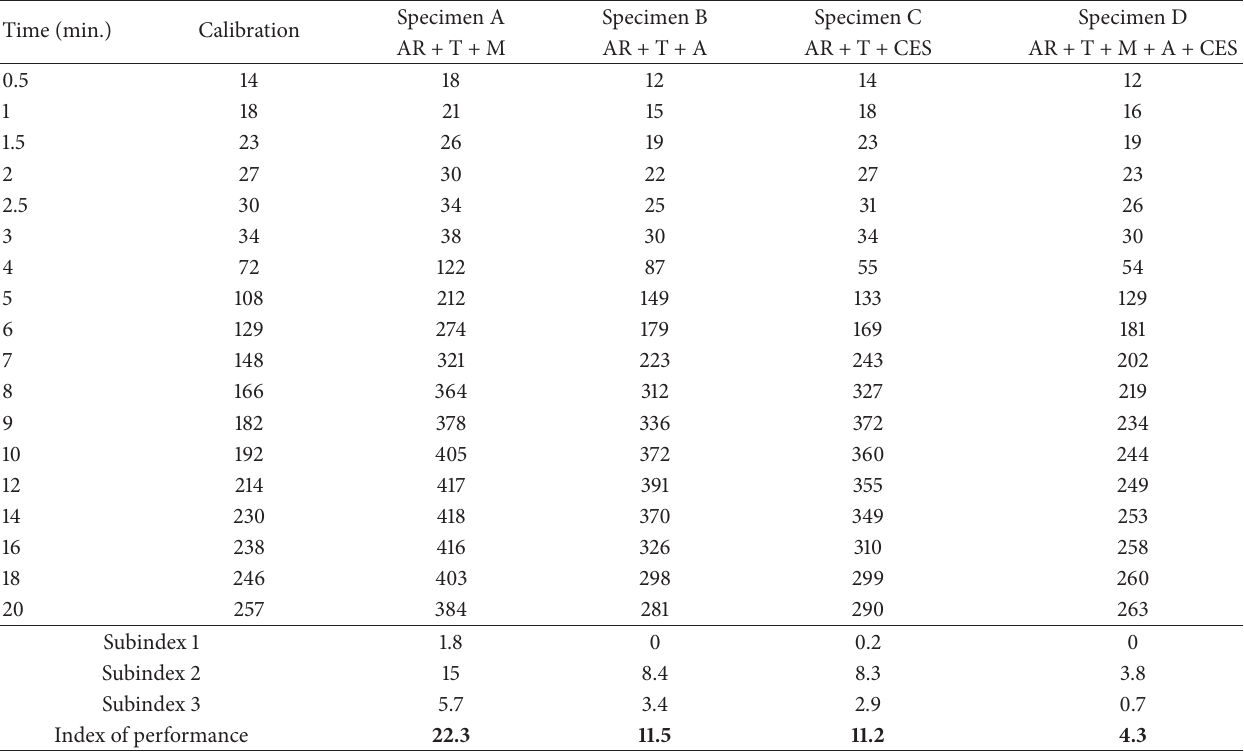
Table 2: Results of fire propagation